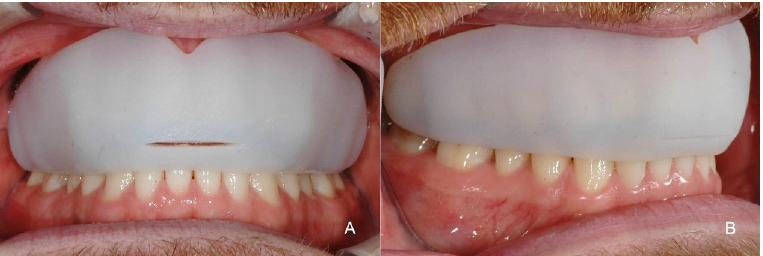
Figure 7. The Polyjet printed multi-material MG in situ, showing a good adaptation to the soft tissue and lower dental arch from the frontal ( A ) and side aspects ( B ). The slit in the middle part shall ensure the air supply, when the teeth are clinched. The outer surface is of micro roughness which may irritate the soft tissues within a short wearing period and calls for further